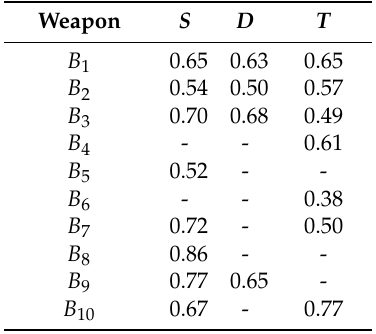
Table 6. Threat vector aggregation of